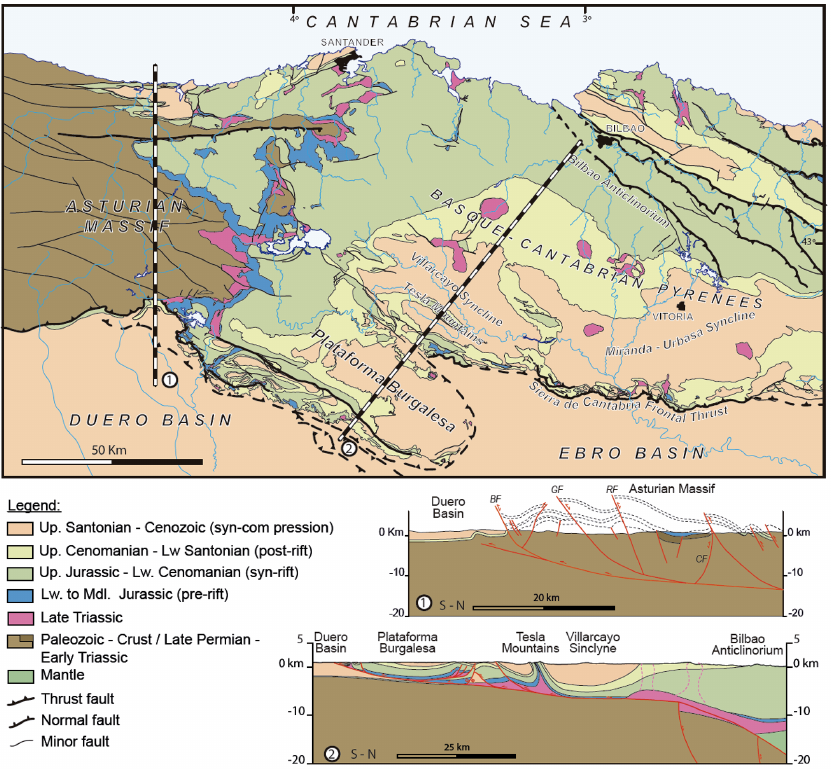
Figure 2. Tectonostratigraphic map of the Basque–Cantabrian Pyrenees–Asturian Massif junction (modified from Miró et al., 2021) and geological cross-section showing the along-strike variability of the structural style, from thick-skinned to the west to thin-skinned to the east. Cross-section 1 from Espina (1996) and cross-section 2 from Miró et al. (2021). BF: Becerril Fault, GF: Golobar Fault, RF: Rumaceo Fault, CF: Cabuérniga